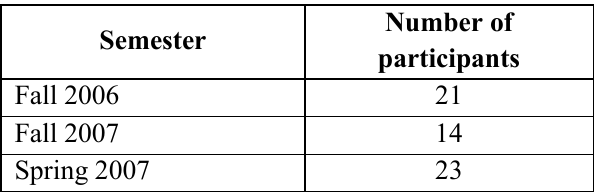
Distribution of the Study’s Participants according to